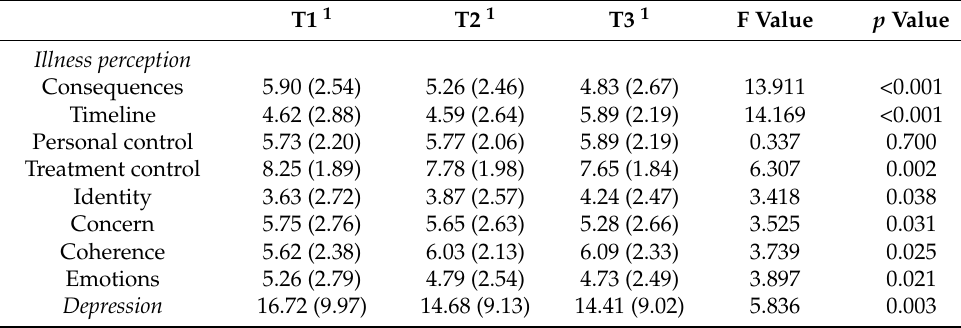
Table 2. Illness perception and depression at three points (T1, T2, and T3).